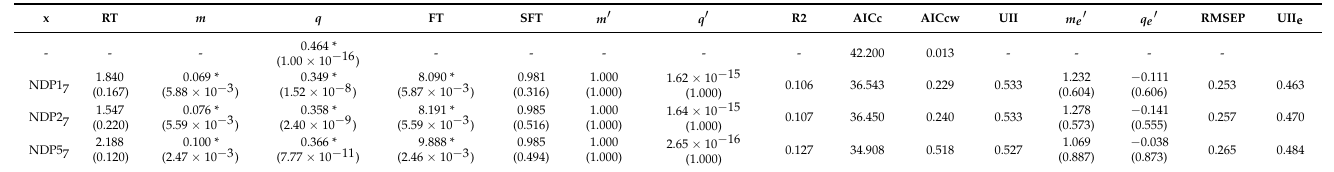
Table 2. Propagule deposition of Cryphonectria parasitica modelled as a function of climatic variables. The table shows the outcomes of the ordinary least squares linear regressions (OLSLR) modelling of the standardized deposition rate (SDR) of C. parasitica based on the number of days with weekly precipitations over 1, 2, and 5 mm (x), namely NDP1 7 , NDP2 7 , and NDP5 7 , respectively. The first row refers to the null model. RT, FT, and SFT are abbreviations for the Ramsey, F, and Shapiro–Francia tests, respectively. The model equation slope ( m ) and intercept ( q ) are reported for all models, with their p -values in brackets. The same coefficients are presented for the slope ( m (cid:48) ) and intercept ( q (cid:48) ) of the regressions between observed and predicted (OP) values of the SDR, but in this case, with expected values m (cid:48) = 1 and q (cid:48) = 0 under the null hypothesis. The index R 2 , Theil’s UII, Akaike criteria AICc and AICcw, and the root mean square error of prediction (RMSEP) are also indicated. Statistics showing “e” in the subscript refer to the external validation of the OLSLR model. When appropriate, the p -value is reported in brackets under the related statistics. The symbol (*) indicates significant values ( p < 0.05).